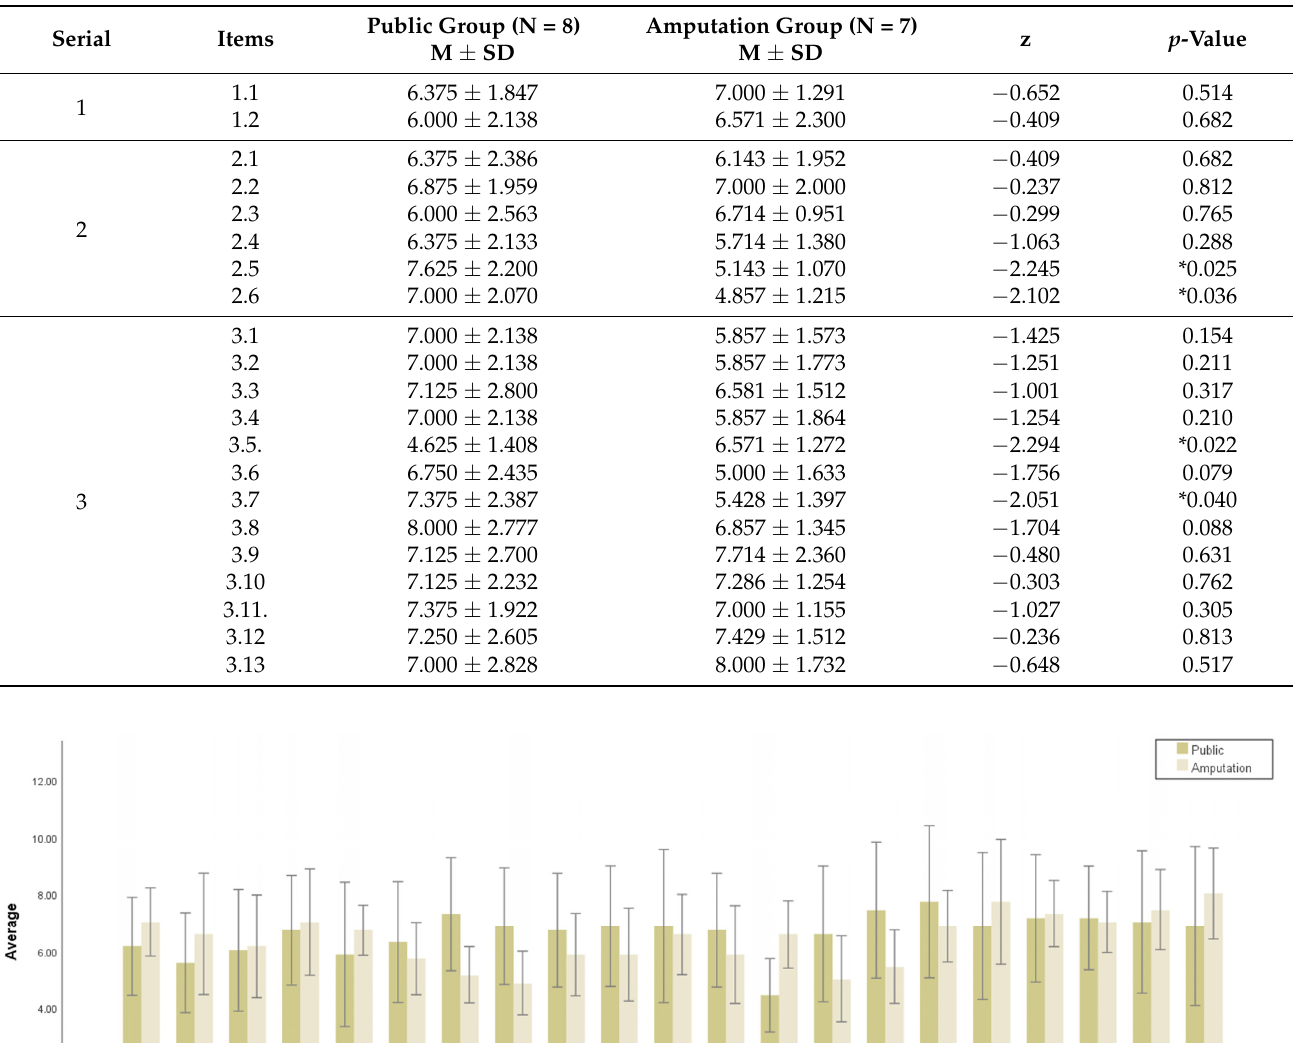
Table 7. Evaluation Results and Scores by Amputated Status.